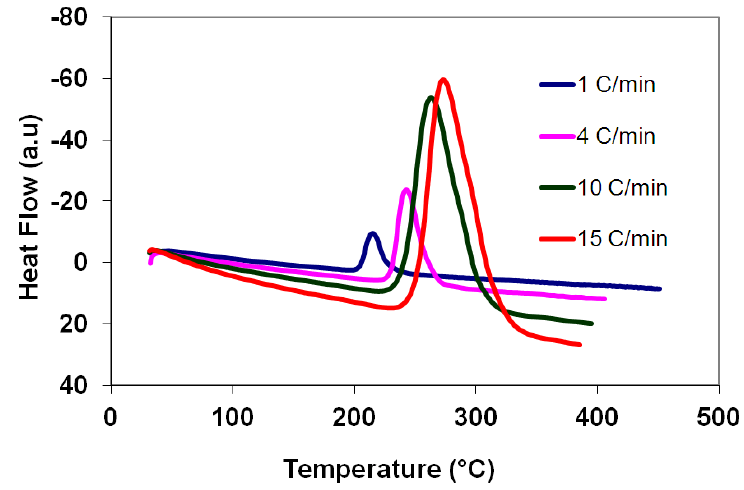
Figure 10. Differential Thermal Analysis (DTA) curves for MgH heating rates of 1, 4, 10 and 15